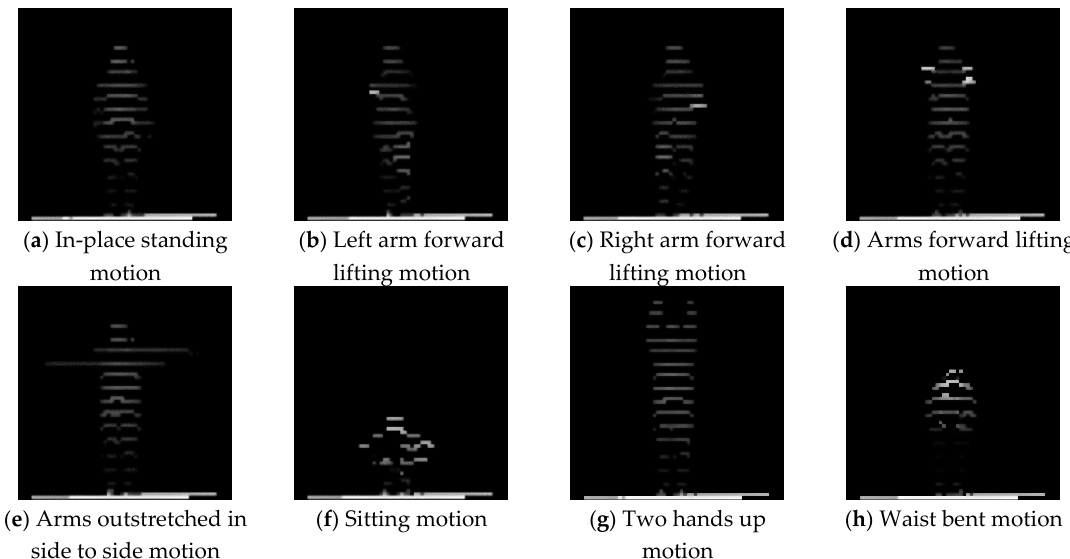
Figure 11. Depth images generated by up-sampling 3D point clouds-based depth images bilateral filtering.